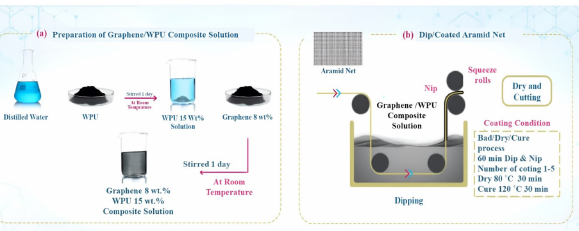
Figure 8. Illustration of the fabrication process for graphene/WPU with dip coating on para-aramid knitted fabric, which consists of two steps: ( a ) preparation of graphene/WPU composite solution, ( b ) dip coating of para-aramid knitted fabric with different coating cycles